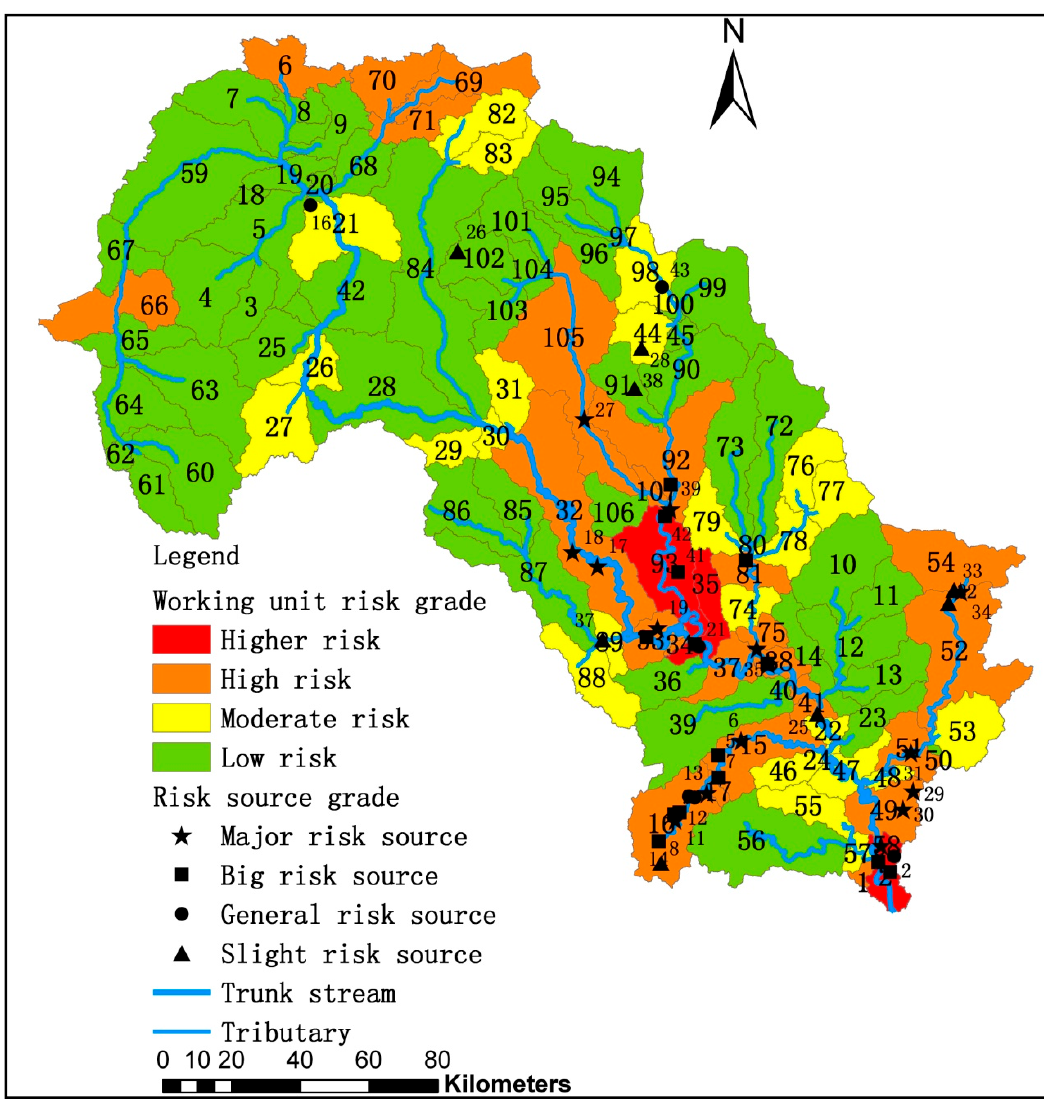
Figure 11. Working unit risk grade distribution map.